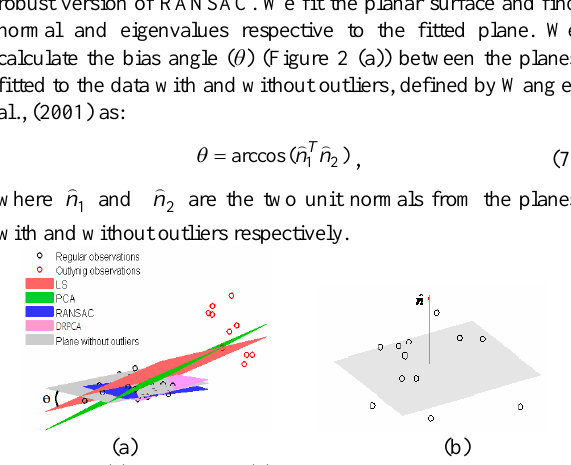
Figure 2. (a) Bias angles ( θ ) between the fitted planes with Table 1. Variances for regular (R) and outlier (O) data and without outliers by different methods (b) variation along the normal to the sample points simulate 1000 sets of sample with 50 points in which 20% are outliers for different combinations of x , y variances. The rows of Table 1 show the variance combinations for regular (R) and outlier (O) data. Other criteria are the same as for the previous datasets. The results presented in Figure 4(a) show that robust methods are better than non-robust methods. Again the average bias angle for DRPCA is significantly less than for LS and PCA, and also better (less) than DPCA, MSAC and RANSAC. It is known that surface thickness (roughness) influences surface fitting methods. To see the effect of roughness, we change the variance along the z (elevation) axis. Again we simulate 1000 datasets of 50 points with 20% outliers. The z variances for regular observations are 0.001, 0.01, 0.02, 0.05, 0.1 and 0.2. The parameters for outliers (mean, variances for x , y and z ) are the same as for previous simulated datasets. Figure 4(b) shows that MSAC and RANSAC get worse compared to others with increasing z -variance.